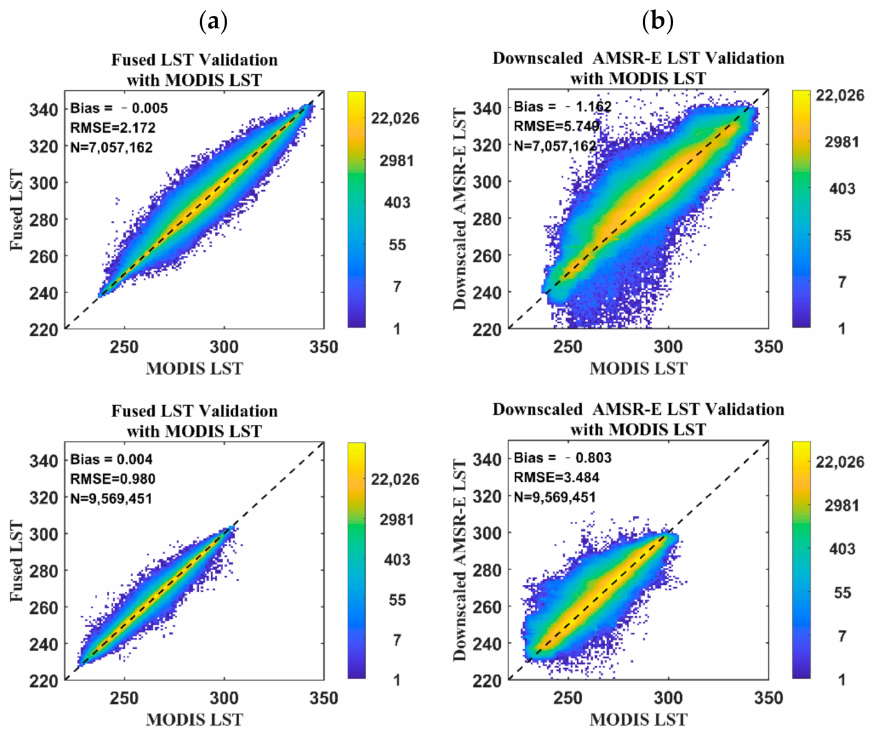
Figure 17. Scatter density plot: ( a ) MODIS LST and fused LST; ( b ) MODIS LST and downscaled AMSR-E LST. The first row is daytime data and the second row is nighttime